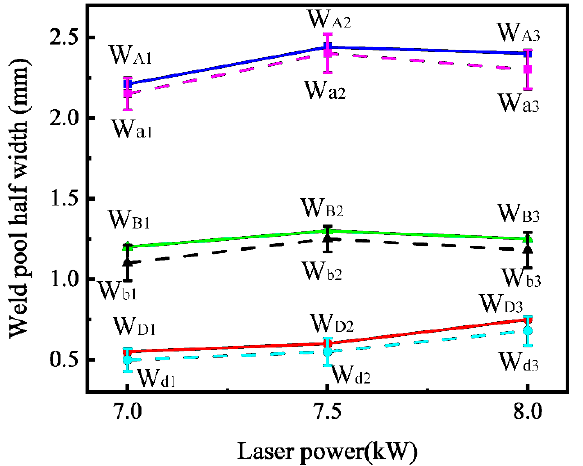
Figure 7. Simulation and experimental results of molten pool